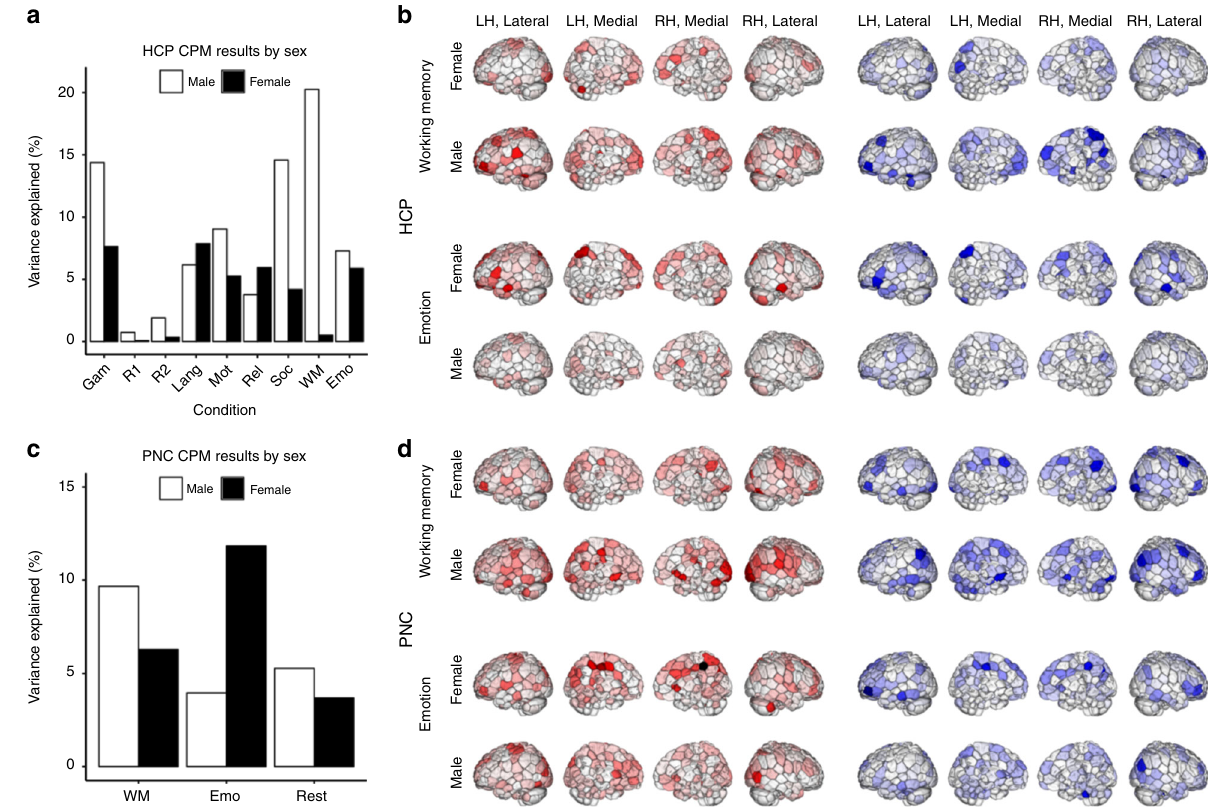
Fig. 3 Distinct networks, best perturbed by different tasks, underlie fl uid intelligence in males and females. a Results from the CPM pipeline run separately for males ( n = 241) and females ( n = 274) on data from each of the 9 HCP conditions (edge-selection threshold of P < 0.01). Abbreviations as in Fig. 1. b Visualization of node degree for male and female HCP models. Abbreviations and conventions as in Fig. 2c. c Results from the CPM pipeline run separately for males ( n = 251) and females ( n = 320) on data from each of the 3 PNC conditions (edge-selection threshold of P < 0.01). Abbreviations as in Fig. 1. d Visualization of node degree for male and female PNC models. Abbreviations and conventions as in Fig.